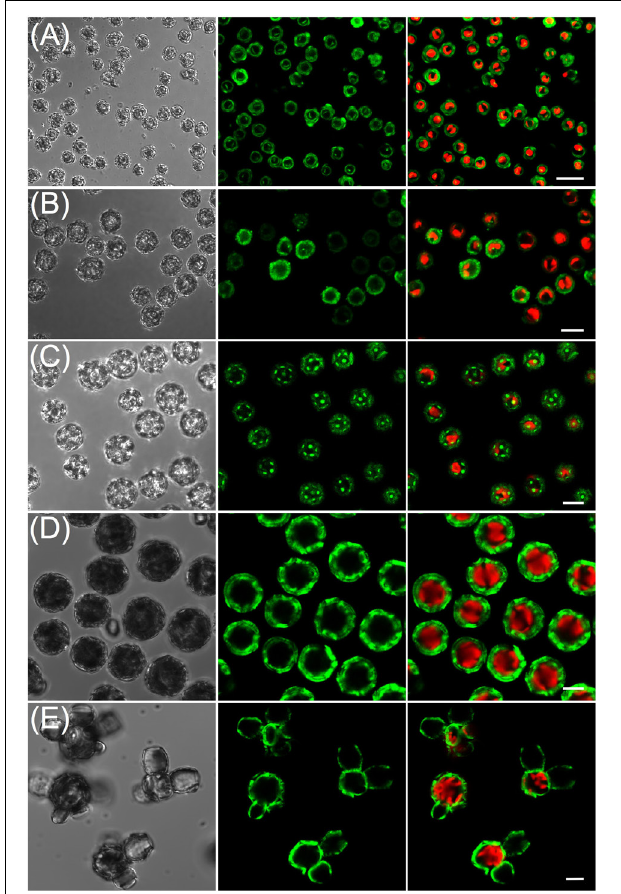
FIGURE 2 | Confocal microscopy of coccolithophore species stained with calcein. Five species of heterococcolithophore cultures were stained for 2 h with 0.2 mM calcein in buffered FSW and then washed before confocal imaging. (A) Emiliania huxleyi ; (B) Gephyrocapsa oceanica ; (C) Calcidiscus leptoporus ; (D) Coccolithus braarudii ; (E) Scyphosphaera apsteinii. Left panels show cells viewed in differential-phase contrast (DIC), middle panels show the calcein channel, and the right hand panel is the chlorophyll autofluorescence (shown in red) with overlay of calcein fluorescence (shown in green). Scale bars represent 10 µ m.